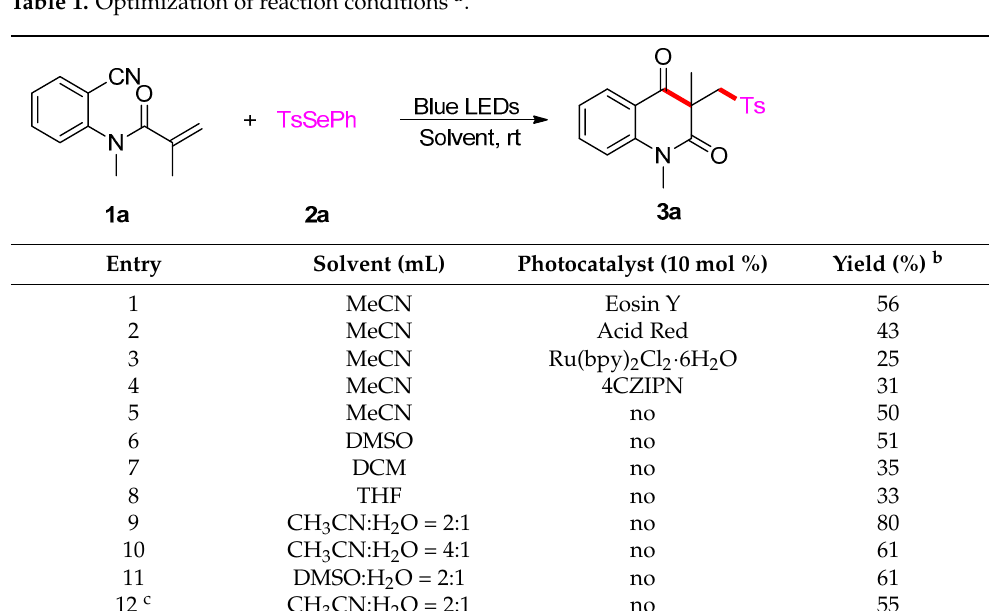
Table 1. Optimization of reaction conditions a .